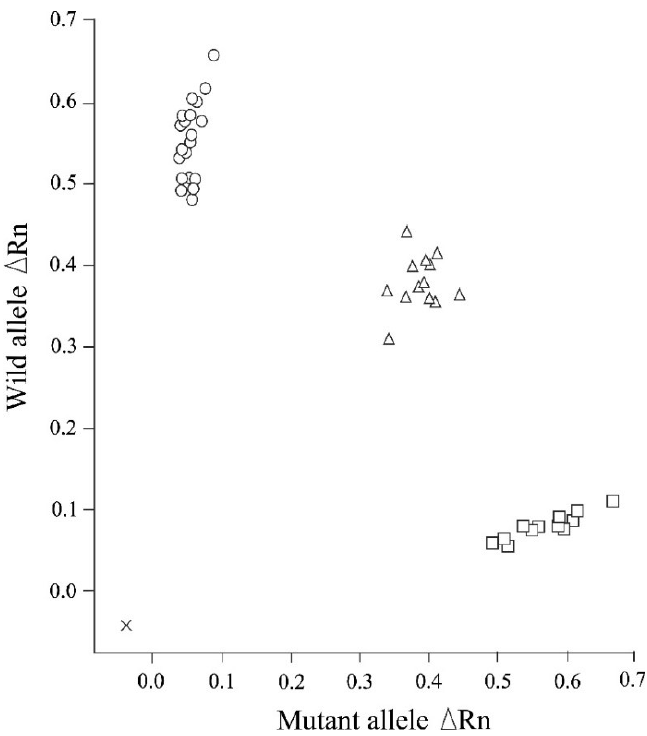
Figure 2. An allelic discrimination plot of end point fluorescence real-time PCR data showing the three genotypes (homozygous wild-type, heterozygous carrier, and homozygous mutant) of neuronal ceroid lipofuscinosis in Chihuahuas. This plot presents the data obtained for 45 representative DNA samples of Chihuahuas that had been previously genotyped. The plot shows the fluorescence intensities (ΔRn values) for each allele. ×: No template control; ○ : Homozygous wild-type genotype (20 samples); ∆: Heterozygous carrier genotype (13 samples); □: Homozygous mutant (affected) genotype (12 samples).